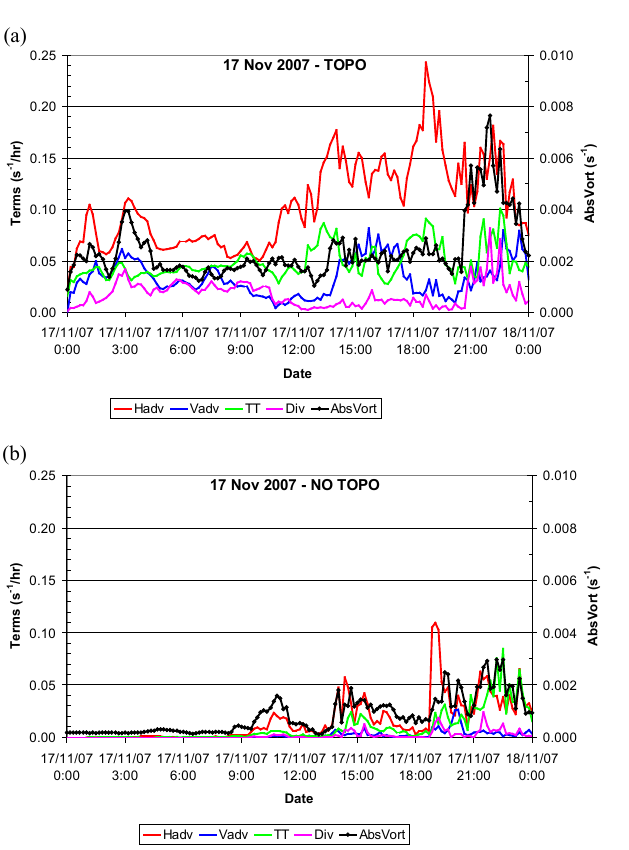
Figure 6. Similar to Fig. 5 but for the case of 12 February 2010. phy in the inner domain box (D3 as described in Sect. 2). The actual topography is illustrated in meters in Fig. 1a. Here- after, for brevity reasons, the numerical simulation results based on modified (reducing) topography of D3 domain will be coded as TOPOMX, where X stands for the percentage (%) of modification. Thus, TOPOM0 means modified topog- raphy by 0 % (actual topography), and TOPOM100 refers to modified topography by − 100 % (without topography). Figure 8a–d, illustrate TOPOM0 (solid lines) and TOPOM100 (dotted lines) simulation results 90 min prior to and 60 min after tornadogenesis for EHI, SRH, BRN, and MCAPE across every tornadic case study. All values for the two sets of simulations (TOPOM0 and TOPOM100) depict the values of diagnostic indices in radii less than 20 km from the tornadogenesis location. The spatial distribution of the four diagnostic variables of TOPOM0 simulations at the time of tornadogenesis is presented in Fig. 9 for each tornado case. The EHI analysis of T07 TOPOM0 numerical simulation reveals significant high values (EHI > 6) prior to tornado- genesis (60 min prior) that gradually increase (EHI = 8) at the time of tornadogenesis (Fig. 8a, solid green line with squares). Figure 9a in fact shows a maximum EHI value (EHI = 8) too close to the tornado location (the distance